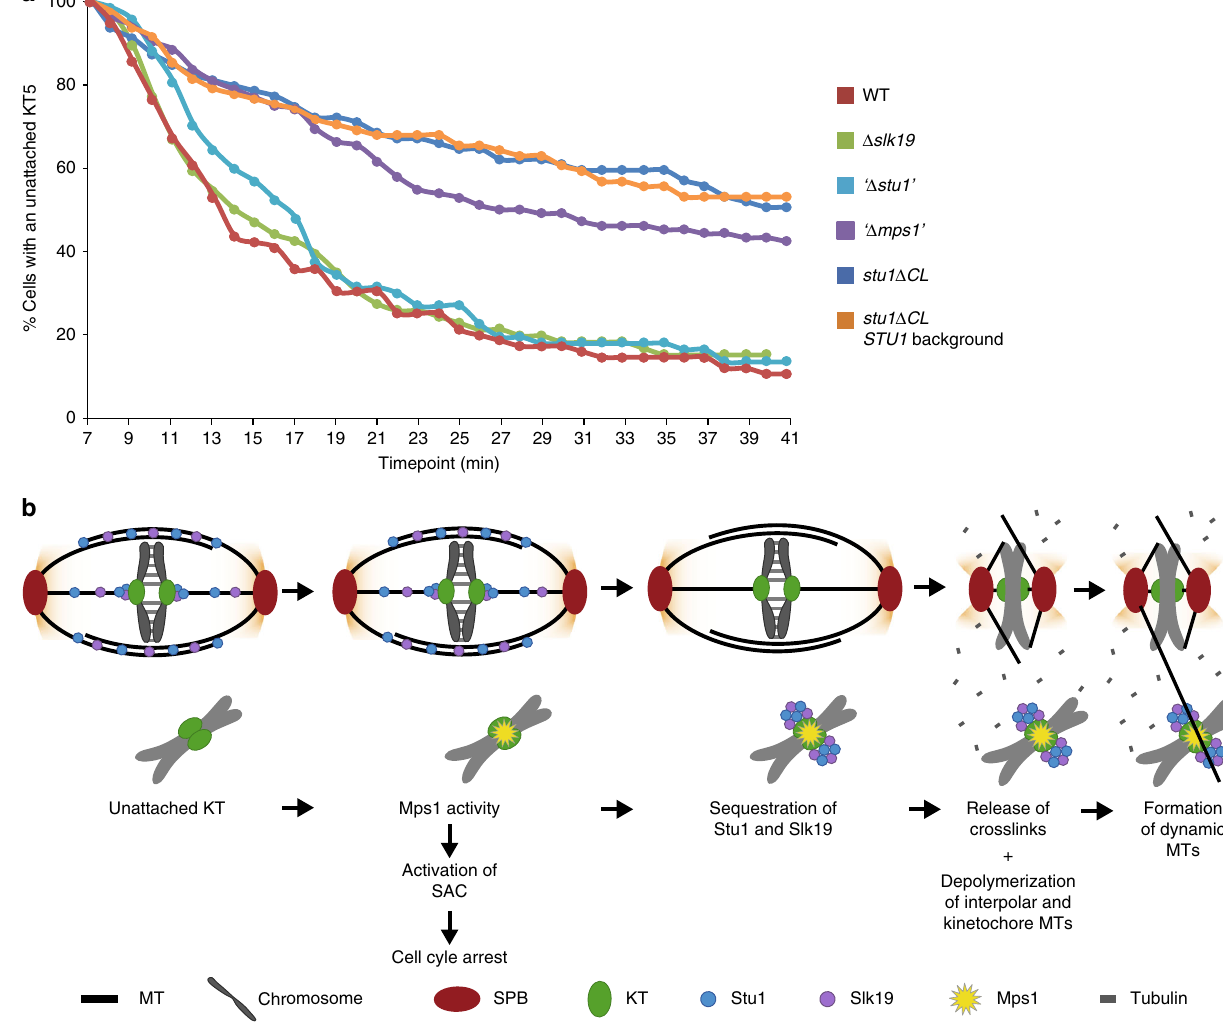
Fig. 6 The enhanced formation of nrMTs facilitates the capturing of uaKTs. a Compromising the mitotic spindle by Stu1 removal is important for ef fi cient capturing of uaKTs. Cells with the indicated genotypes (see Supplementary Table 1) were arrested in metaphase and uaKTs were produced as described in Fig. 2. Cells were observed in 1 min time intervals and the number of cells with an uaKT was determined. The number of cells with an uaKT observed 7 min after KT reactivation (see Supplementary Table 3) was set to 100%. The data shown is the result of one out of two independent experiments performed. Both had a very similar outcome. b Proposed model how sequestering of Stu1 and Slk19 enhances the formation of nrMTs, and thus promotes capturing of uaKTs. Mps1 localized at an uaKT induces the binding of Stu1 to this uaKT. This initiates the sequestering of Stu1 and Slk19 at the uaKT. Consequently, Stu1 and Slk19 are withdrawn from the spindle resulting in the depolymerization of kMTs and ipMTs. The free tubulin produced in this way then promotes